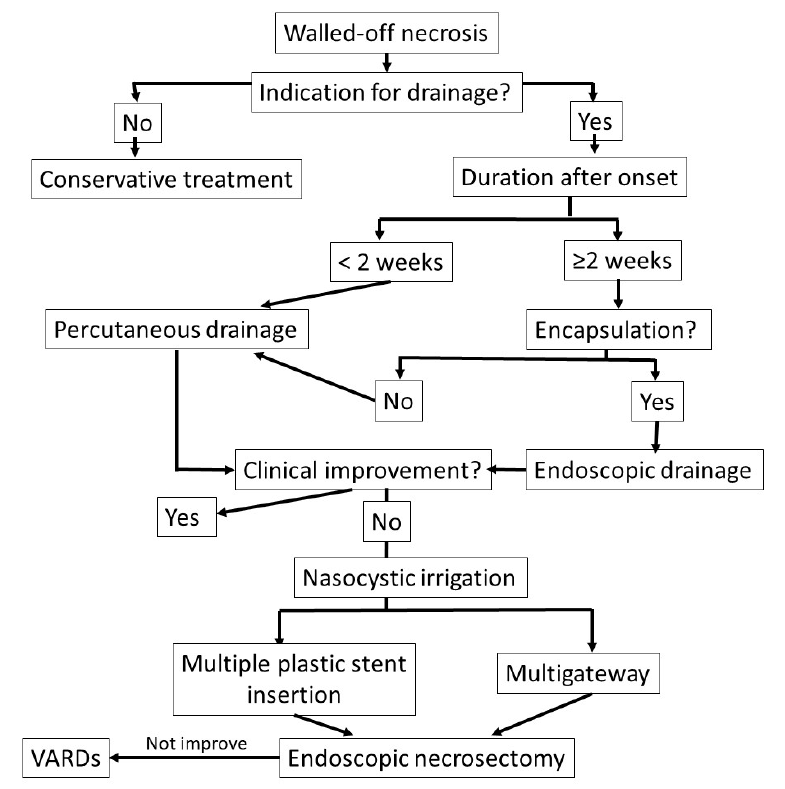
Figure 4. Proposed algorithm for the timely management of walled-off necrosis drainage and necrosectomy. Figure4.